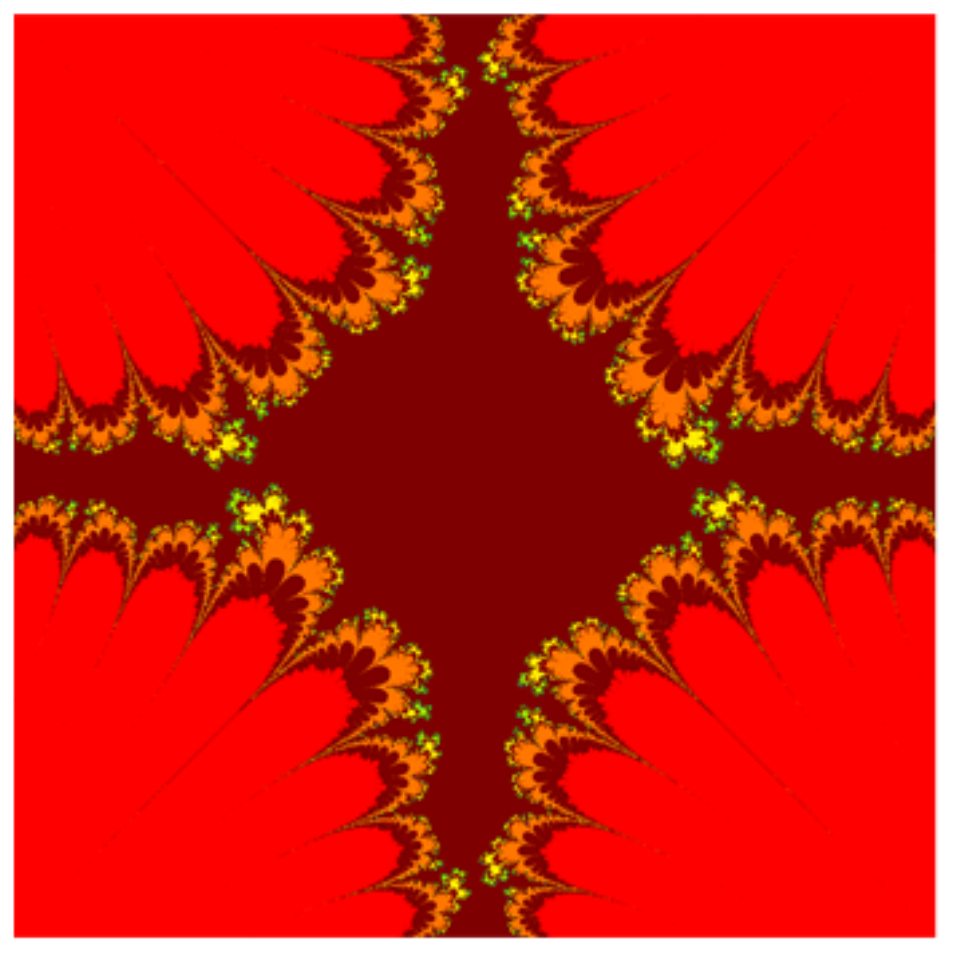
Figure 1. J-set for τ ( z ) = sin ( z 2 ) + c via DKIS. The image execution time is 322.22